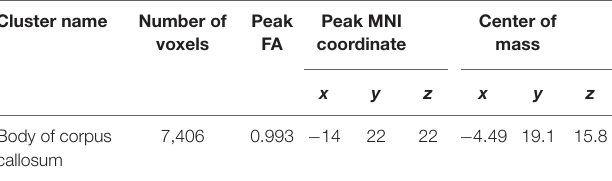
TABLE 4 | MNI coordinates of the corpus callosum showing FA decreases due to chronic